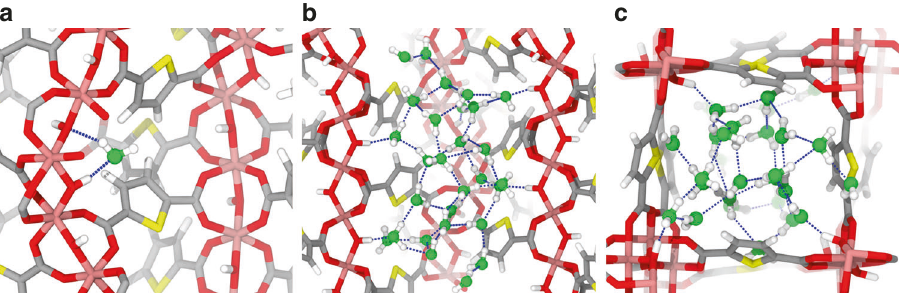
Fig. 3 Preferential arrangement of the adsorbed water molecules within the channel of CAU-23. a The very fi rst adsorbed water molecule interacting with two adjacent µ -OH sites forming strong hydrogen bonds. b Aggregation of hydrogen-bonded water molecules within the channel of CAU-23 plotted along the cross-section of the channel. c Top view of the water loaded